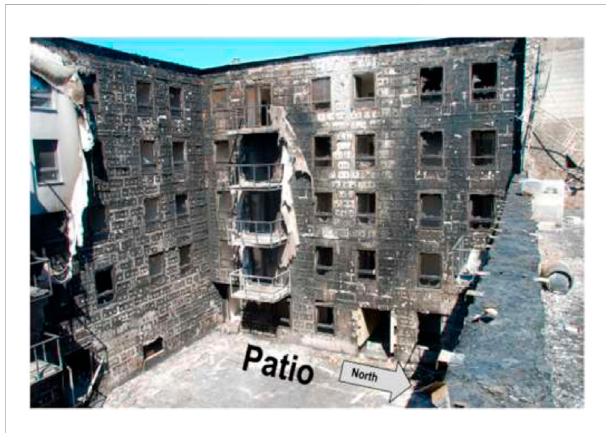
FIGURE 1 Fire consequences (Wróblewski and Stawiski,